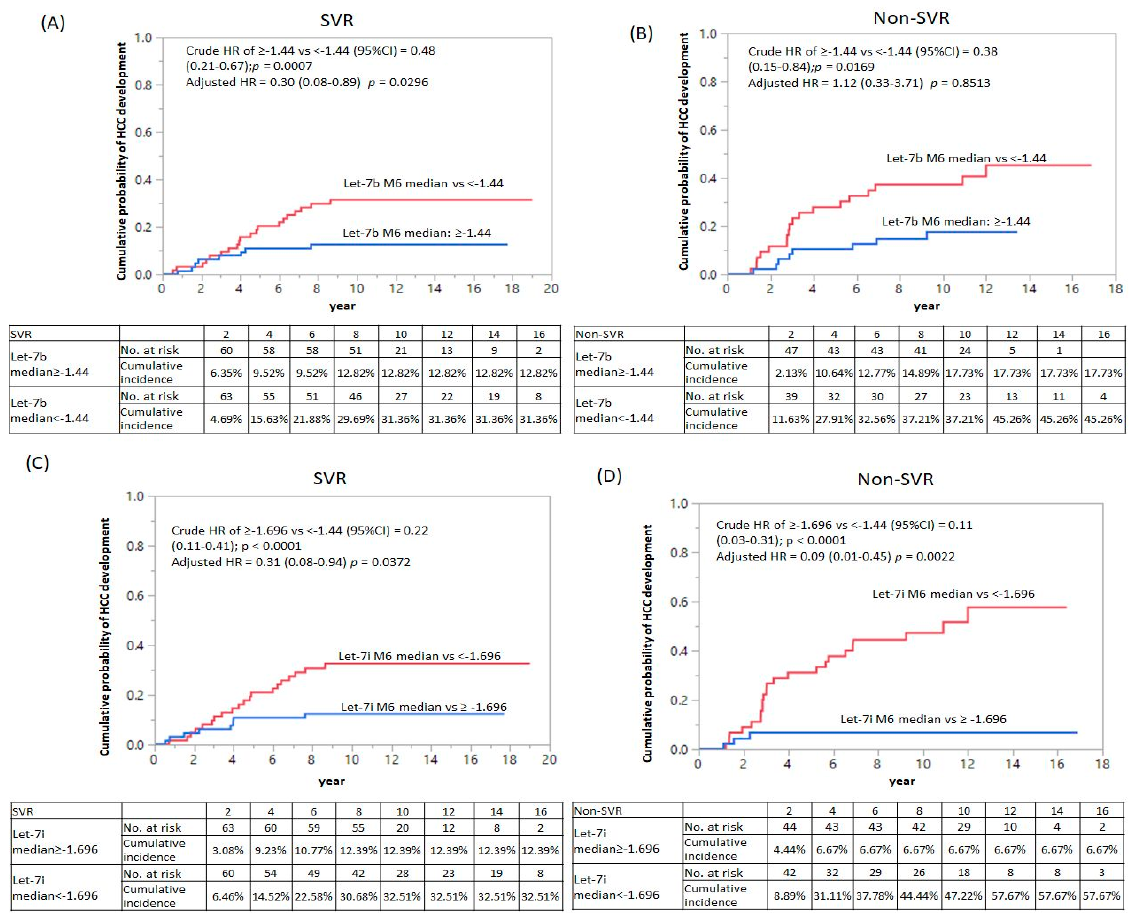
Figure 1. Kaplan-Meier survival analysis of let-7b and let-7i with HCC development in SVR and non-SVR group. Comparison of the cumulative probability of HCC development divided cut-off value from the median value of the distribution of Let-7 expression based on Log 10 2ˆ − delta Ct method in ( A ) let-7b in SVR group, ( B ) let-7b in the non-SVR group, ( C ) let-7i in SVR group, and ( D ) let-7i in the non-SVR group. HR: Hazard ratio; CI: Confidence interval; HCC: Hepatocellular